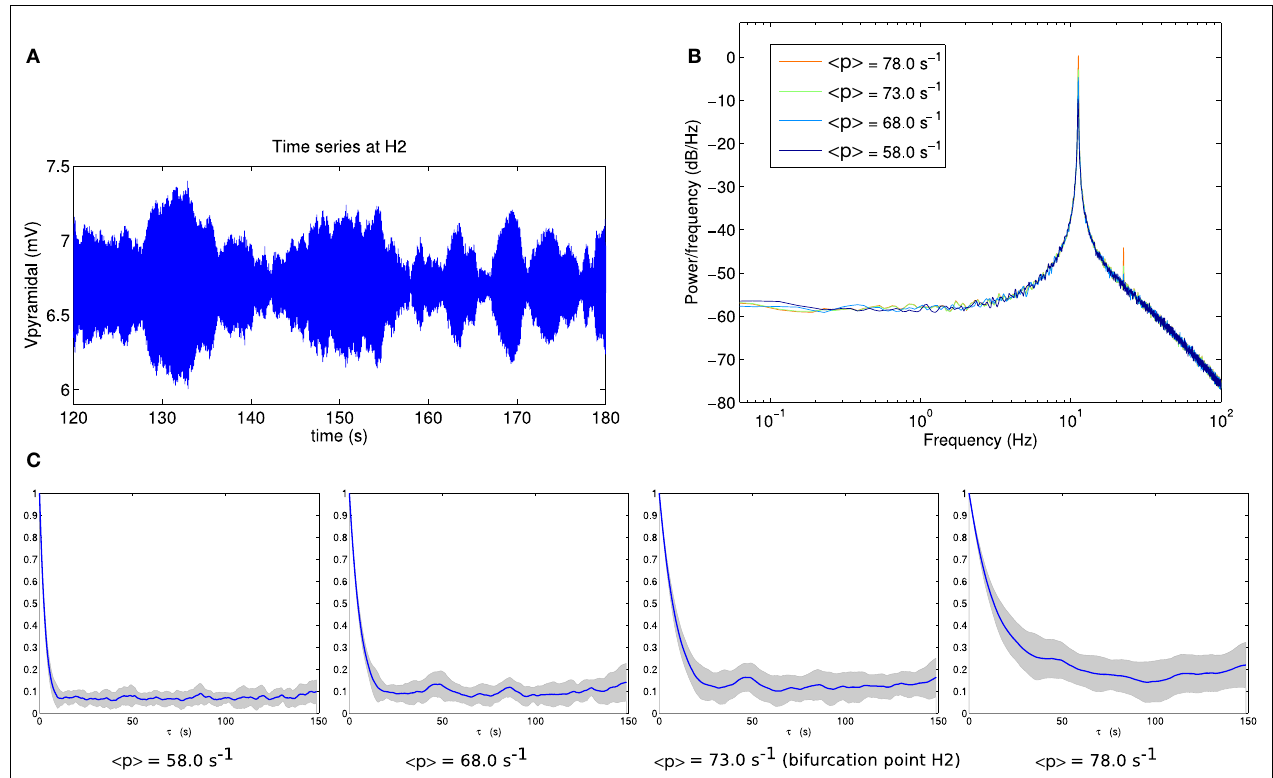
< p > = 68.0s − 1 ), at the bifurcation point H2 (< p > = 73.0s − 1 ) and beyond the bifurcation point (< p > = 78.0s − 1 ).The line indicates the mean over 16 trials and the gray area indicates one standard